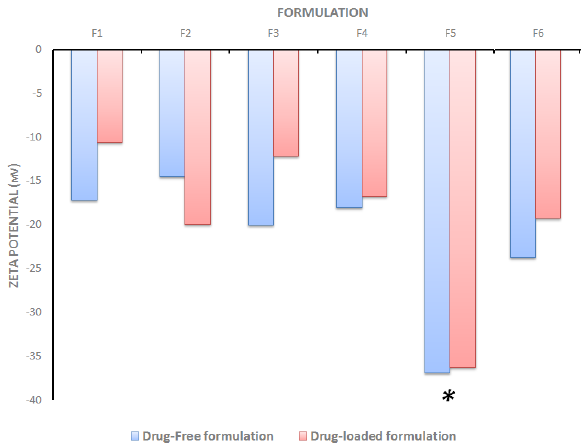
Figure 4. Influence of the drug loading on formulation zeta potential. * denotes statistical significance ( p < 0.05) from all other formulations.